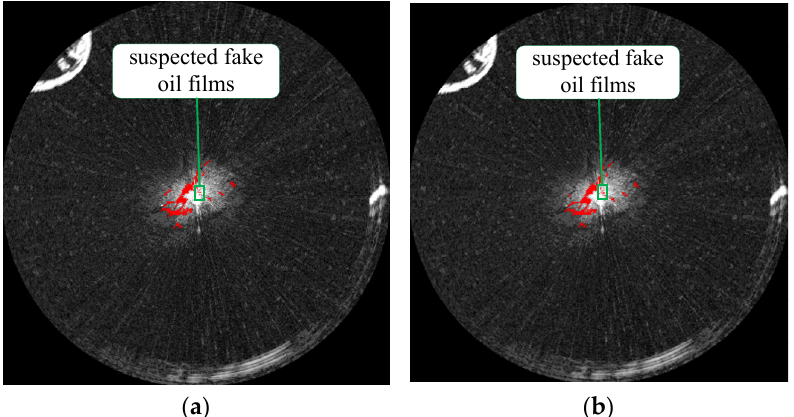
Figure 18. Oil identi fi cation of image texture features and machine learning. ( a ) LBP feature and K- means classi fi cation result; ( b ) Contrast feature of GLCM and SVM.